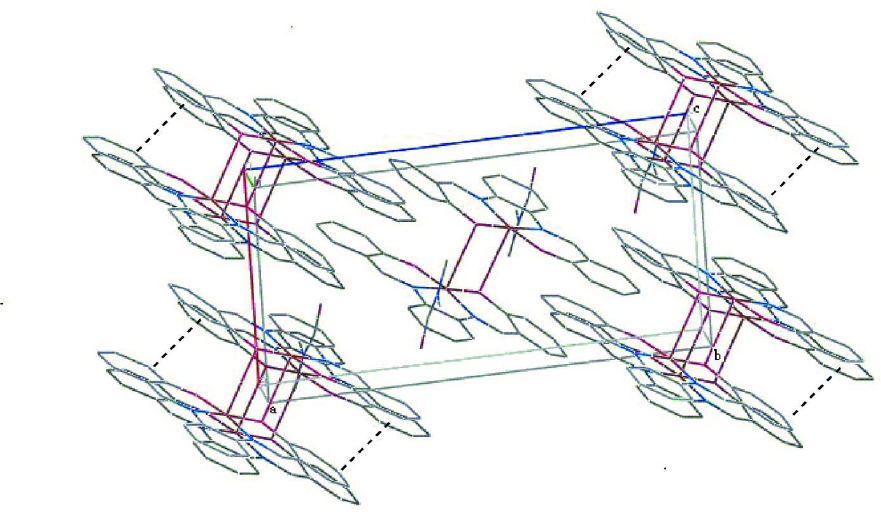
Figure 2 The molecular packing diagram of